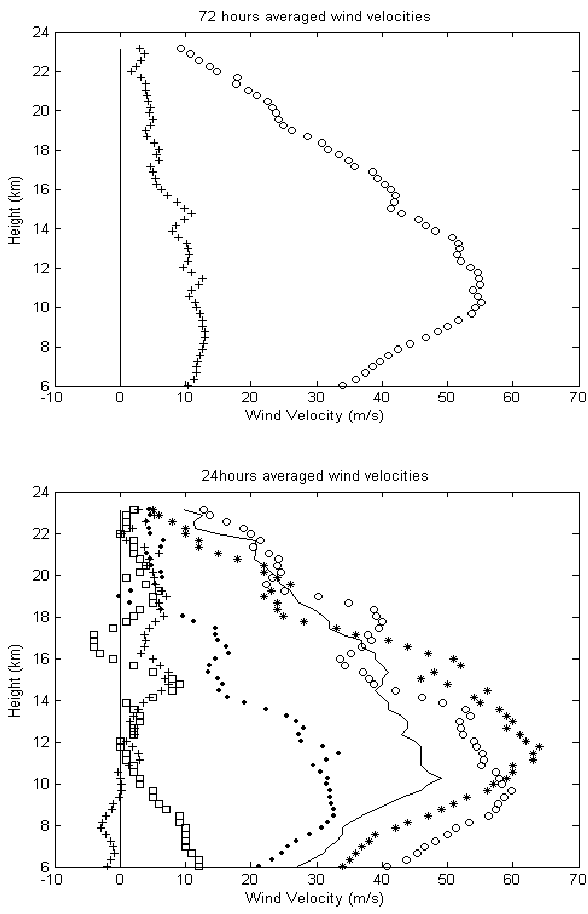
Fig. 1. Upper panel shows the 72h averaged velocity profiles of Fig.1 Upper panel shows the 72 hours averaged velocity profiles of zonal wind (open circle) zonal wind (open circle) and meridional wind (cross); lower panel and meridional wind (cross); Lower panel shows the 24 hours averaged velocity shows the 24h averaged velocity profiles: “open circle” for the 1st profiles: ’open circle’ for the 1 st day zonal wind,, ‘line’ for the 2 nd day zonal wind, ‘star’ day zonal wind, “line” for the 2nd day zonal wind, “star” for the 3rd for the 3 rd day zonal wind; ‘dot’ for the 1 st day meridional wind, ‘cross’ for the 2 nd day day zonal wind; “dot” for the 1st day meridional wind, “cross” for meridional wind, and ‘square’ for the 3 rd day meridional wind.. The starting time of the 2nd day meridional wind, and “square” for the 3rd day merid- ional wind. The starting time of observation was 12:28 on 5 January observation was 1228 on January 5 in 1988.